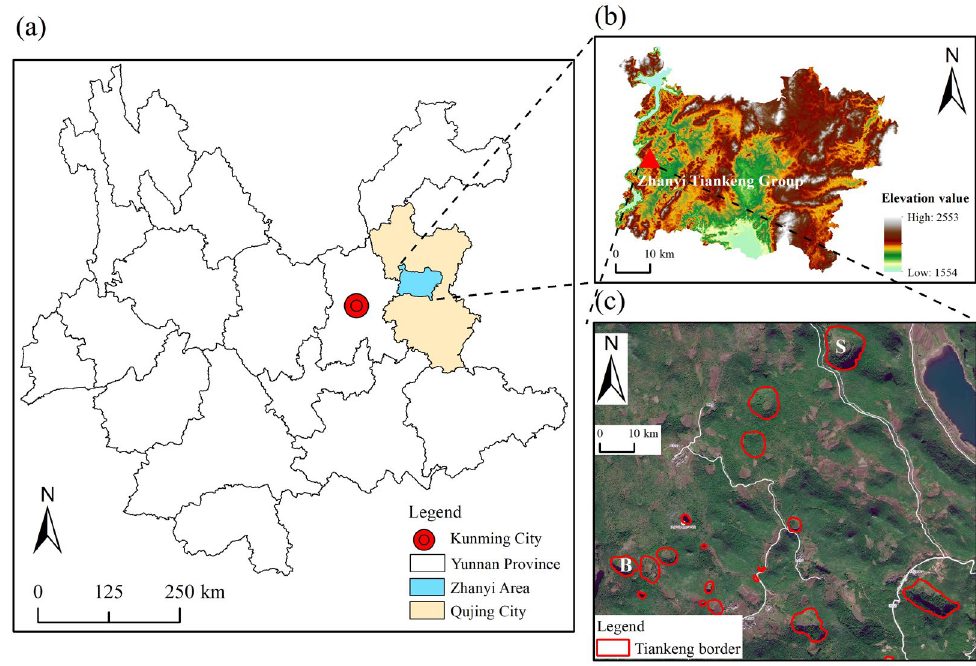
Figure 1. A location map of the karst tiankeng group area. ( a ) Location map (province, city and district) where the study area is located; ( b ) Elevation map of Zhanyi district; ( c ) Schematic diagram of Zhanyi Tiankeng Group. Red circled areas are the border of different tiankengs. B means Bajiaxiantang tiankeng, S means Shenxiantang tiankeng.